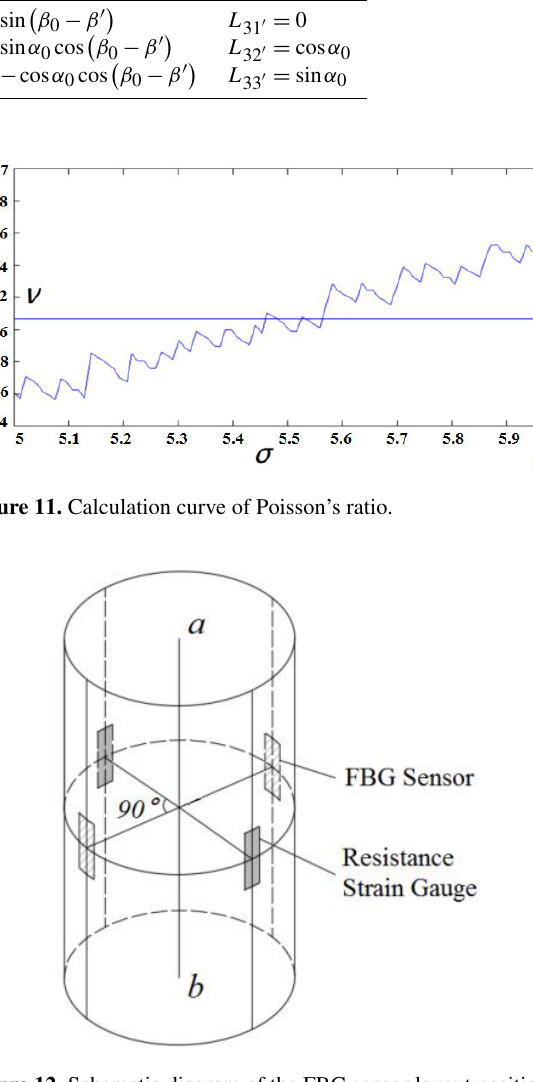
Figure 12. Schematic diagram of the FBG sensor layout